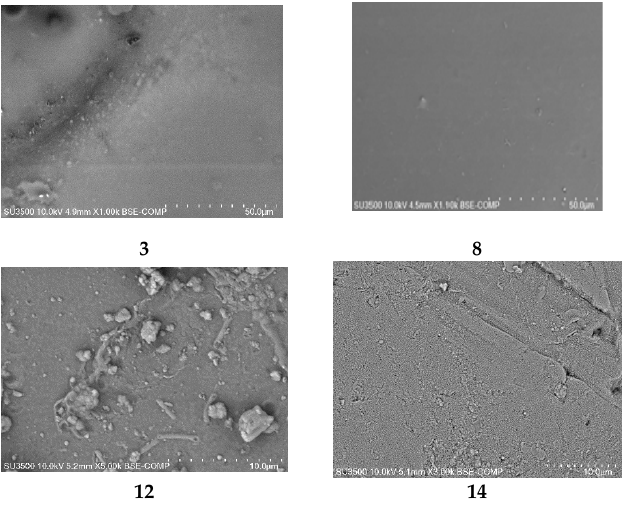
Figure 9. SEM-views of PIMs with 1-octylimidazole ( 3 ), 1-octyl-2-methylimidazole ( 8 ), 1-octyl-4-methylimidazole ( 12 ), and 1-octyl-2,4-dimethylimidazole ( 14 ) [61].